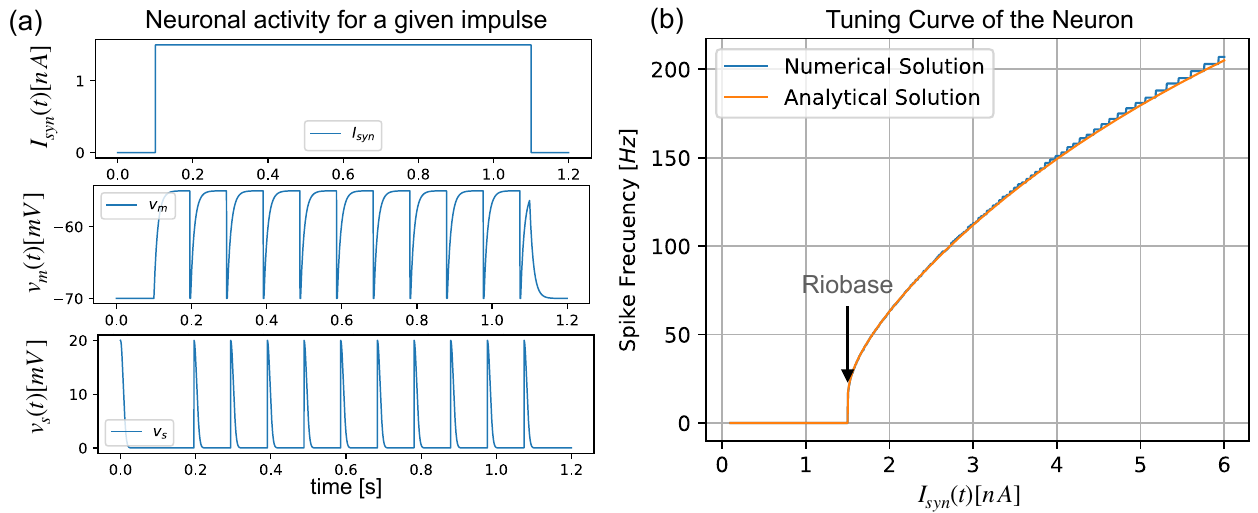
Figure 1. ( a ) Membrane voltage v m ( t ) and spike voltage v s ( t ) of an LIF neuron for an excitatory input current of I syn = 1.5001 nA . ( b ) Tuning curve of the neuron, which shows the riobase value for the parameters given in Table 1. Table 1. Neuron, synapse, and encoding parameters. LIF Model Parameter Value Membrane charging constant τ m = 10 ms Membrane resistance Capacitance of the